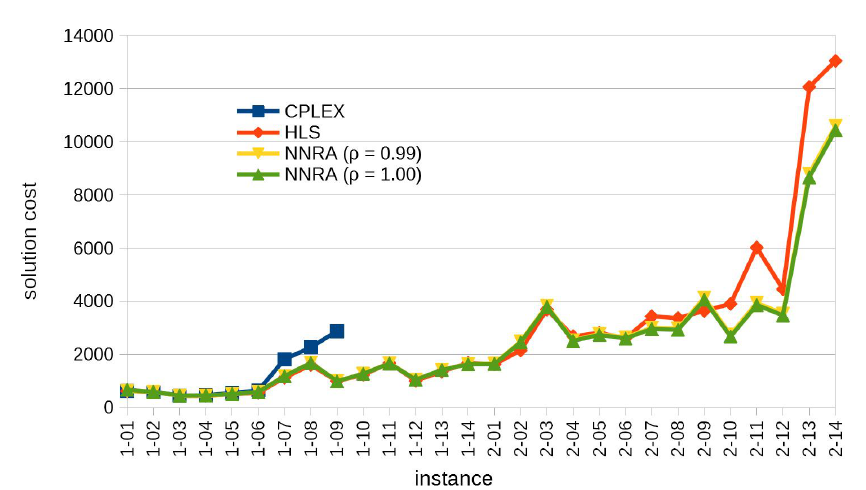
Figure 4. Plot of solution cost versus